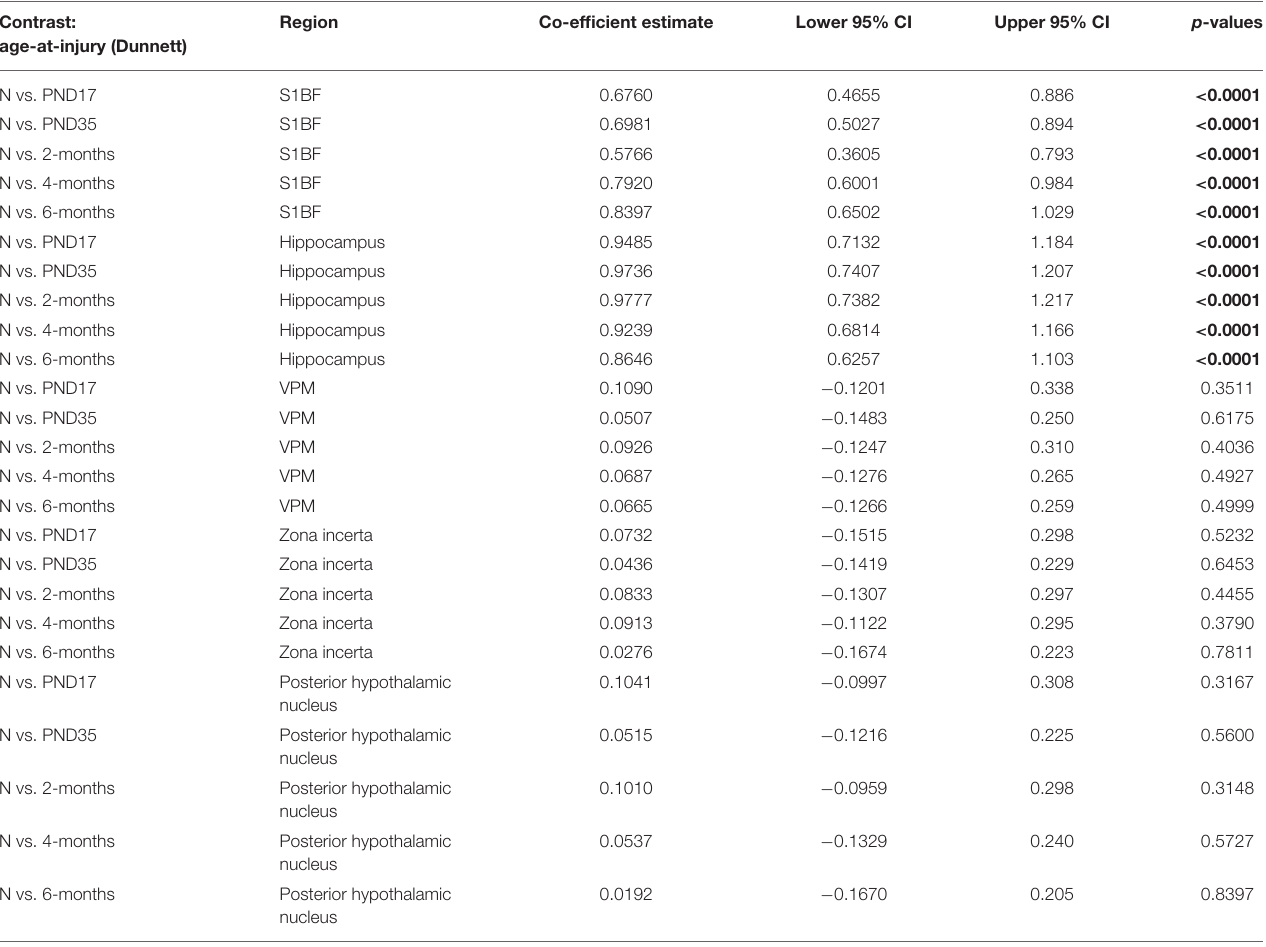
TABLE 4 | Deramified microglia post-hoc contrasts between age-at-injury groups and naïve controls, separated by region, using the Dunnett’s procedure. Contrast: age-at-injury